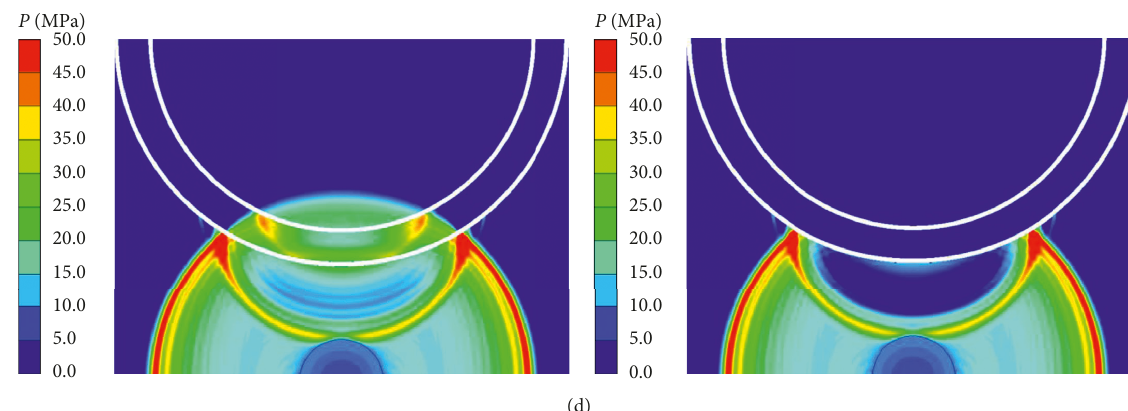
Figure 10: Comparison of the shock wave propagation when the double-layer shell was filled with water (the left column) and air (the right column). (a) t � 3 . 63 θ . (b) t � 5 . 20 θ . (c) t � 6 . 30 θ . (d) t � 7 . 09 θ .